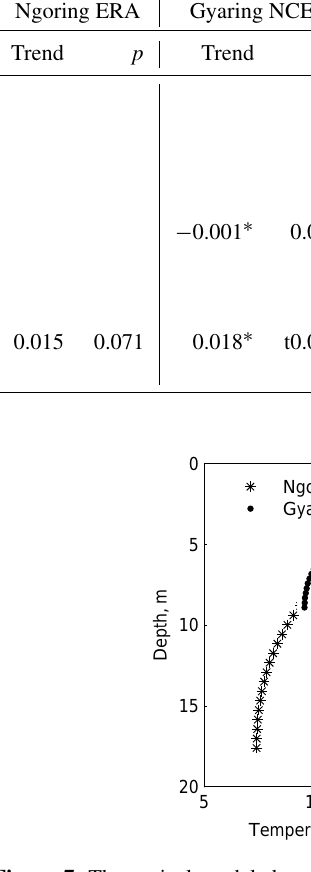
Figure 7. The typical modeled vertical profiles of temperature in Ngoring (stars) and Gyaring (circles) in the middle of the summer stratification period (12 August